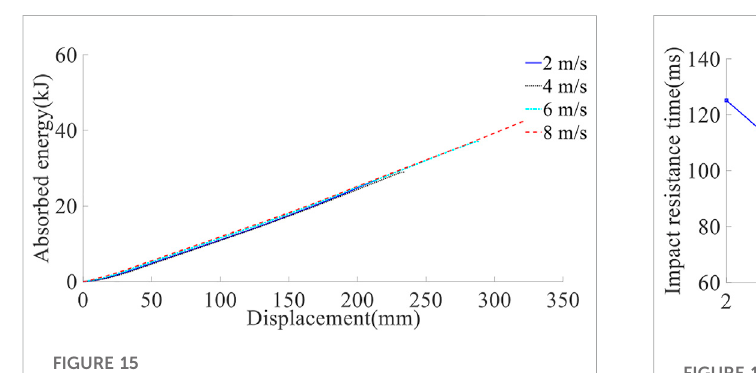
FIGURE 17 Anchor impact resistance time for different impact